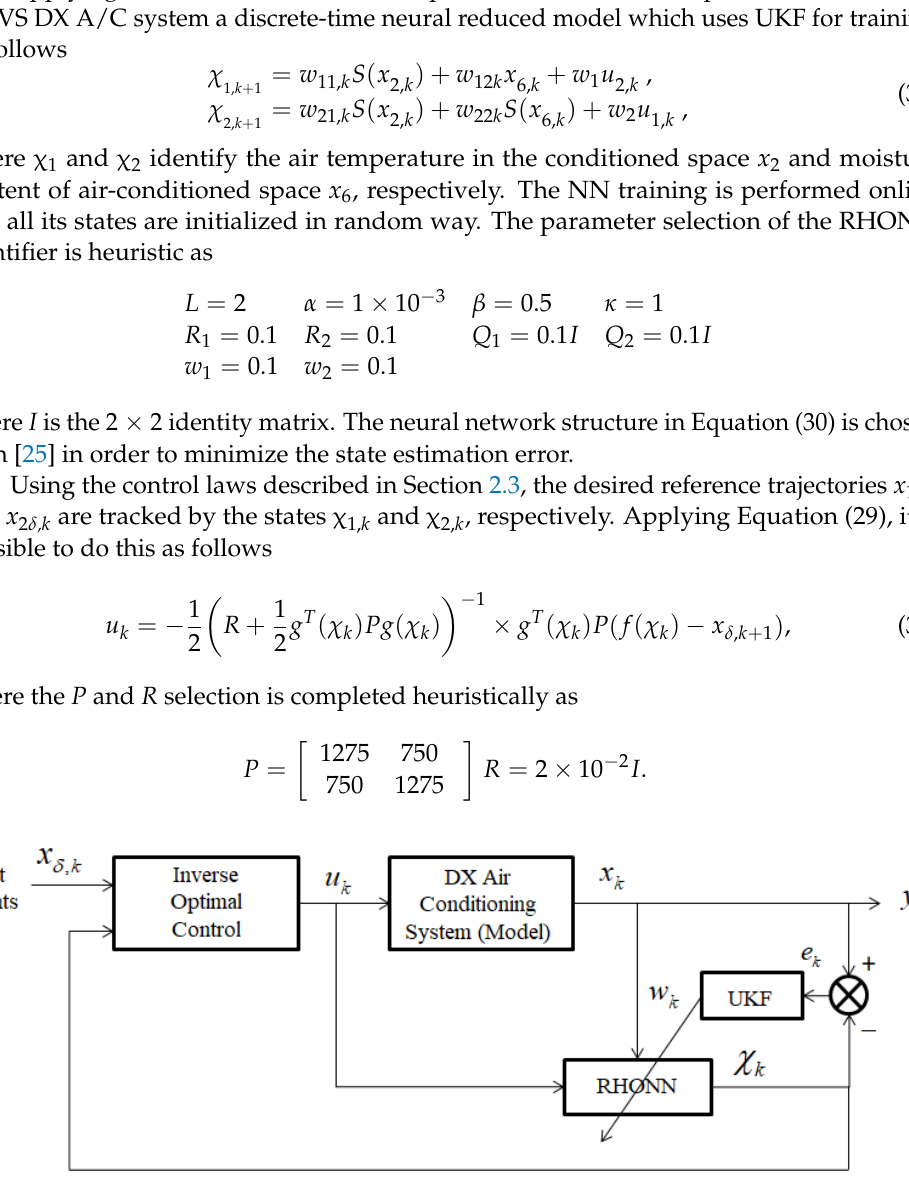
Figure 2. Proposed identification and control scheme.